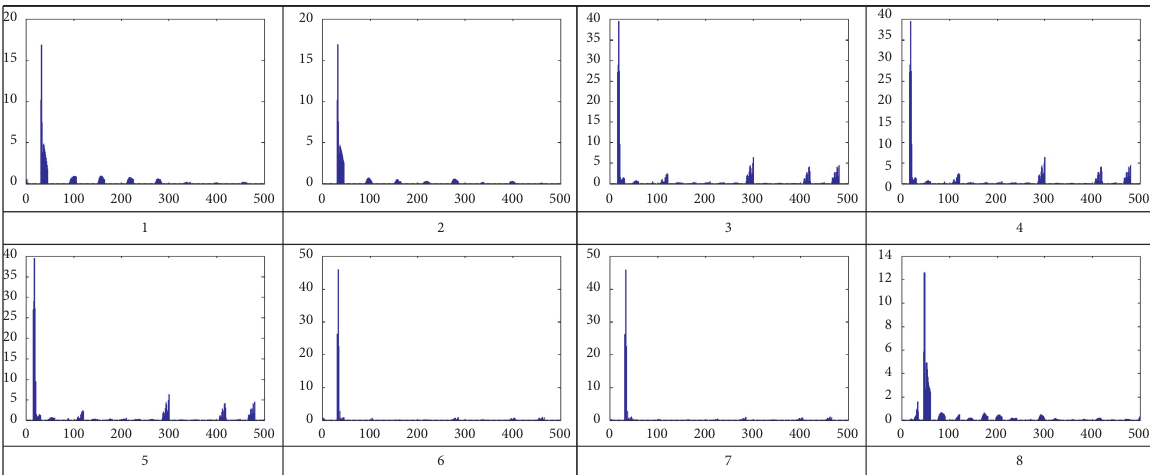
Figure 17: RTMs of the first 8 modes of the FE model.